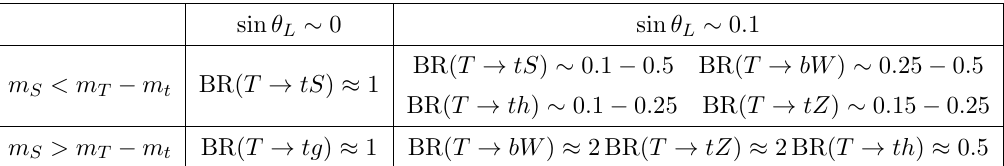
Table 2 . Branching ratios of dominant top partner decay modes for di(cid:11)erent mixing angles and mass regions.